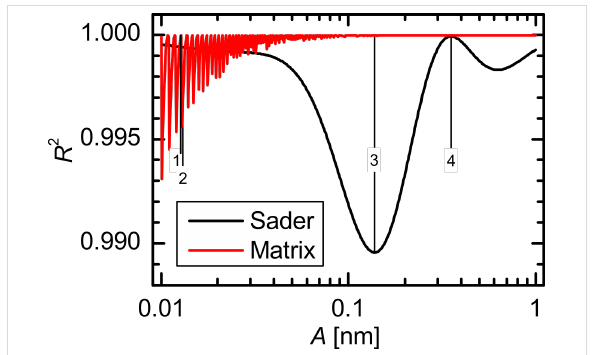
Figure 2: Amplitude dependence of the CoD for the Morse force law. The positions marked with 1, 2, 3, and 4 correspond to the amplitudes 12.8 pm, 12.9 pm, 137 pm and 352 pm,